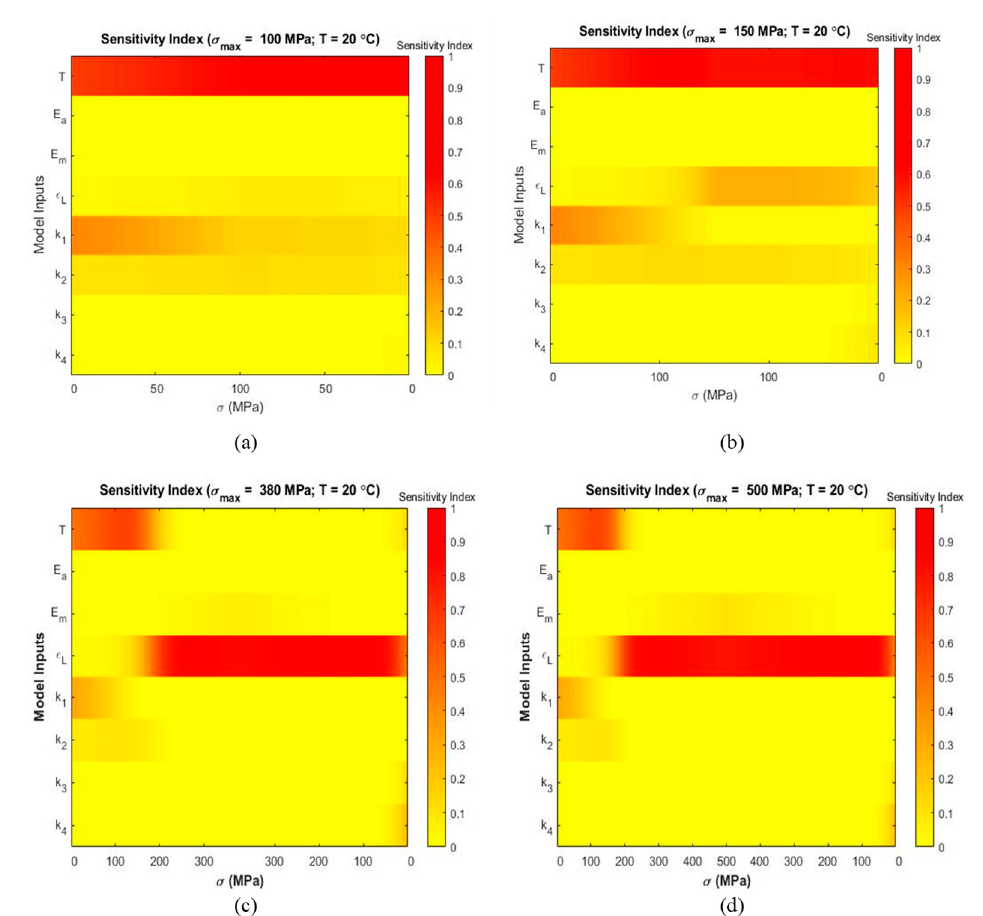
Figure 6. Sensitivity index distribution during loading and unloading based on eFAST sensitivity analysis at simulated temperatures (the corresponding stress values are shown in horizontal axis and the inputs are shown in vertical axis): ( a ) T = 20 °C, σ (cid:2923)(cid:2911)(cid:2934) = 100 MPa ( b ) T = 20 °C, σ (cid:2923)(cid:2911)(cid:2934) = 150 MPa ( c ) T = 20 °C,σ (cid:2923)(cid:2911)(cid:2934) = 380 MPa ( d ) T = 20 °C, σ (cid:2923)(cid:2911)(cid:2934) = 500 MPa.